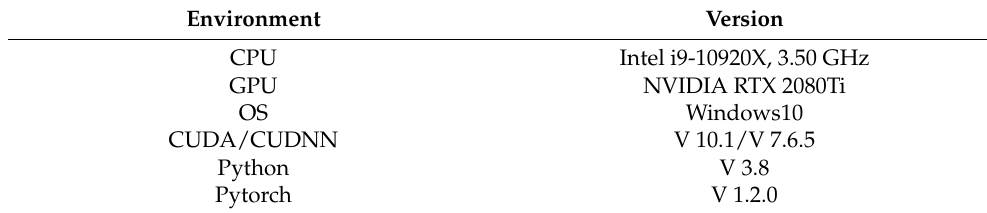
Table 2. Experimental configurations used in this paper.